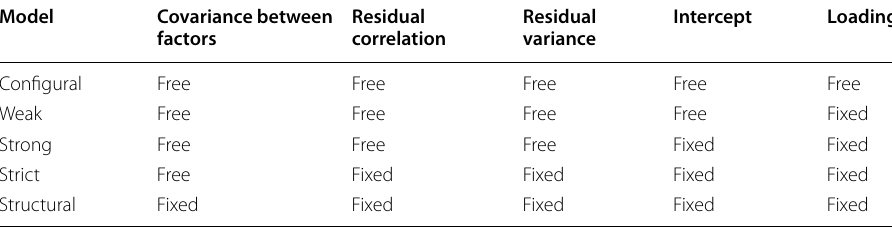
Free indicates that the parameters were freely estimated for each country. Fixed indicates that the parameters were fixed to be the same between countries